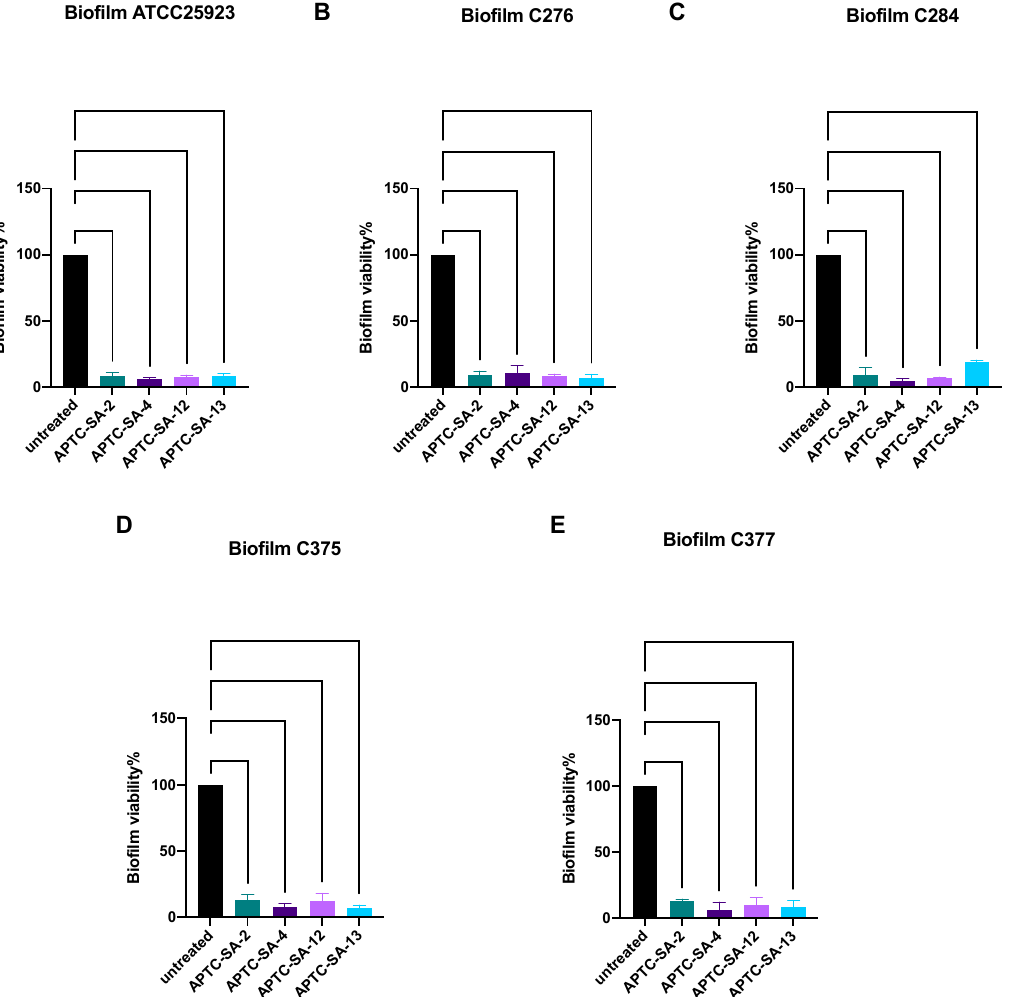
Figure 4. Biofilm assay. S. aureus biofilm ( A ) ATCC25923, ( B ) C276 (MSSA), ( C ) C284 (MSSA), ( D ) C375(MRSA), and ( E ) C377(MRSA) were treated with S. aureus phage (10 8 PFU/mL) for 24 h fol- lowed by crystal violet assays to quantify the biofilm biomass. Significance was determined com- pared to untreated control. Data expressed as mean SD for three independent experiments.